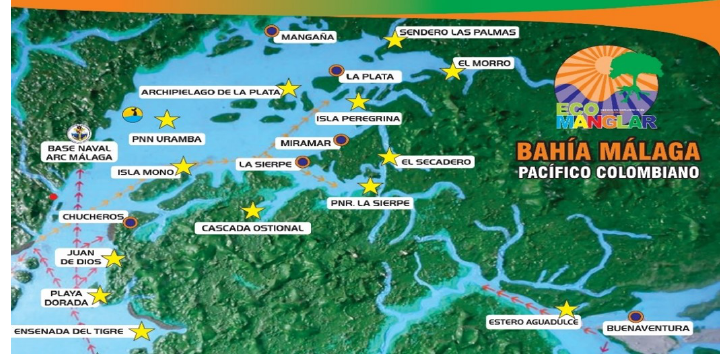
Figure 11. Geographical location Bahía Málaga